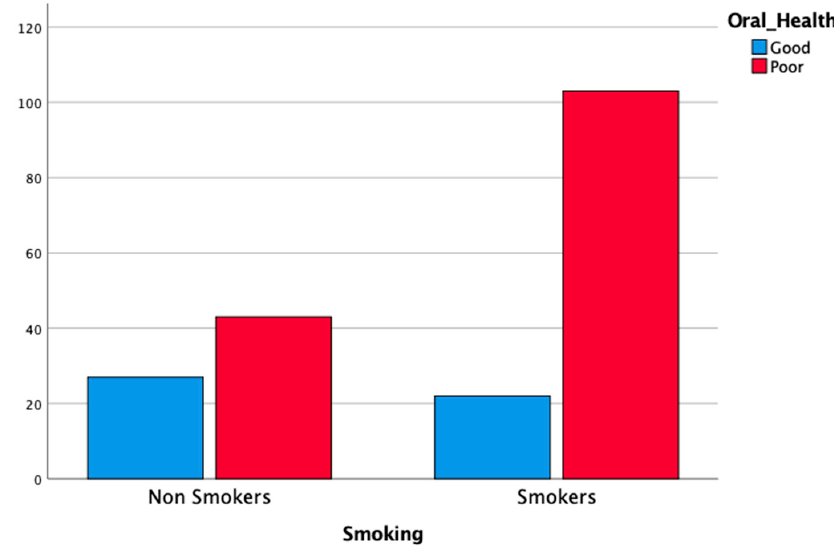
Figure 3. Distribution OH status according to the habit of smoking.